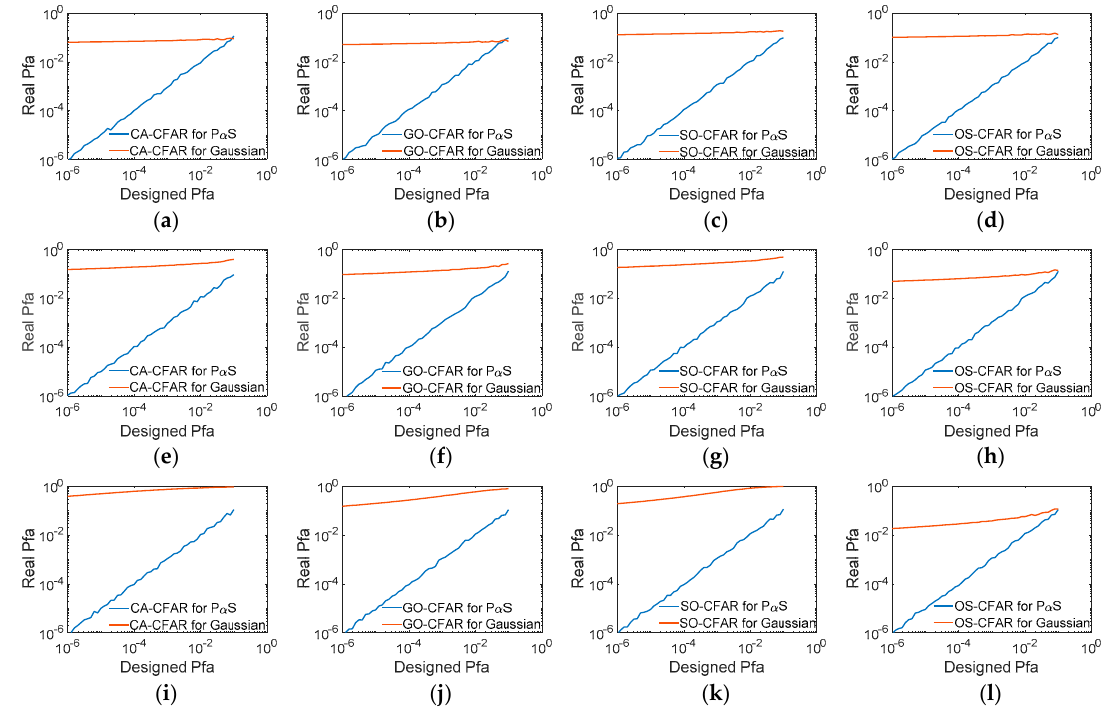
Figure 2. Real probability of false alarm (Pfa) versus designed Pfa in a homogeneous positive alpha-stable (P α S) background. The parameters are N = 32 and γ = 1. ( a ) CA, α = 0.2; ( b ) GO, α = 0.2; ( c ) SO, α = 0.2; ( d ) OS ( k = 28), α = 0.2; ( e ) CA, α = 0.5; ( f ) GO, α = 0.5; ( g ) SO, α = 0.5; ( h ) OS ( k = 28), α = 0.5; ( i ) CA, α = 0.8; ( j ) GO, α = 0.8; ( k ) SO, α = 0.8; ( l ) OS ( k = 28), α = 0.8.